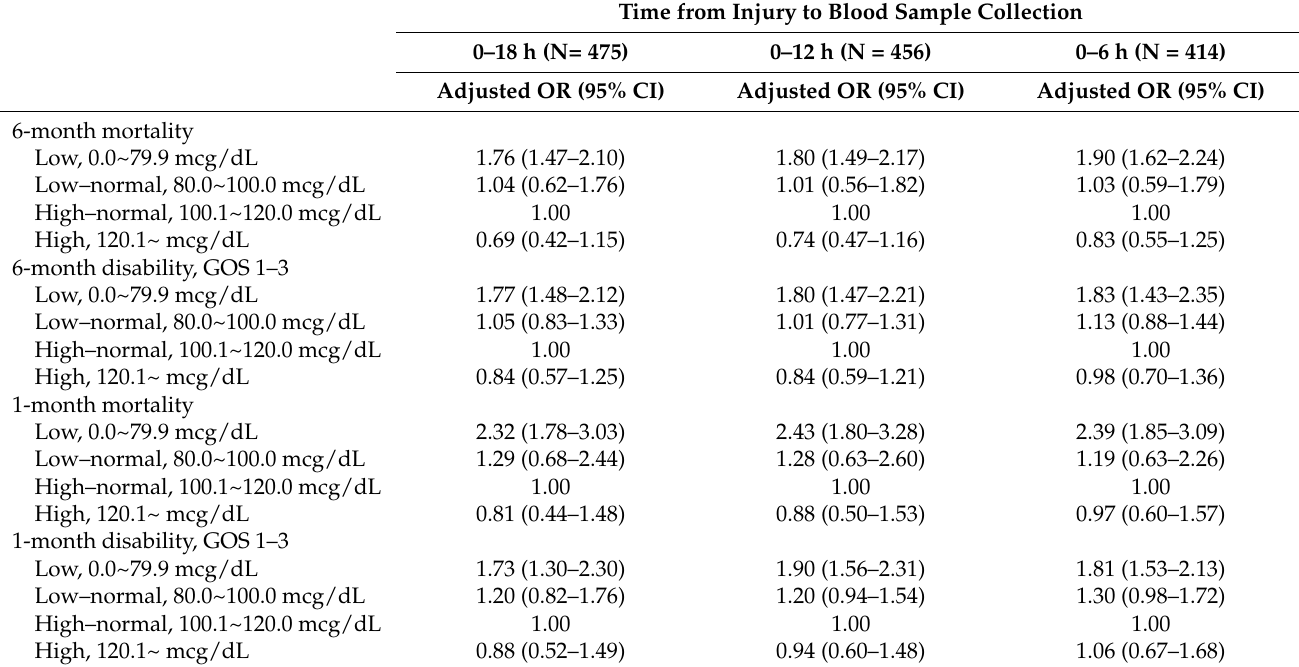
Table 3. Sensitivity analysis according to time from injury to blood sample